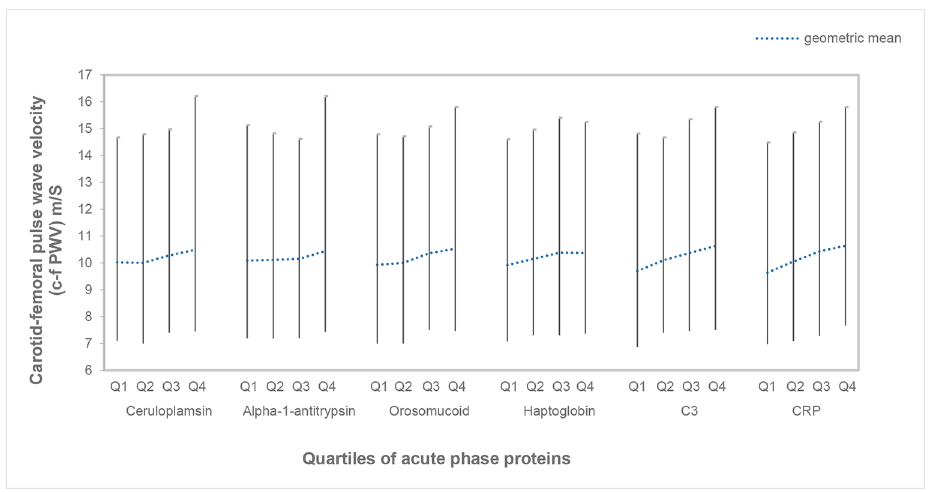
Fig 2. Geometric means and 5th to 95th percentiles of c-f PWV in different quartiles of acute phase proteins.